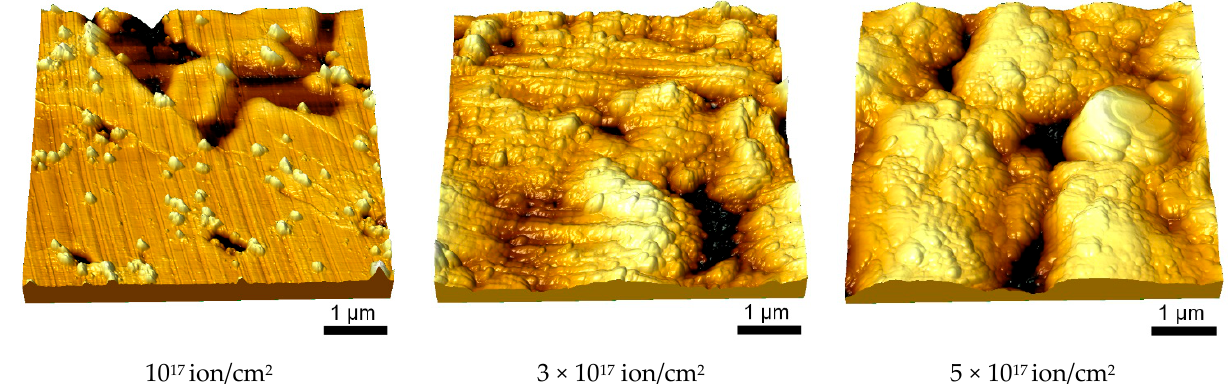
Figure 14. Results of AFM microscopy of changes in the surface relief of SiC ceramics at high irra- diation doses. irradiation